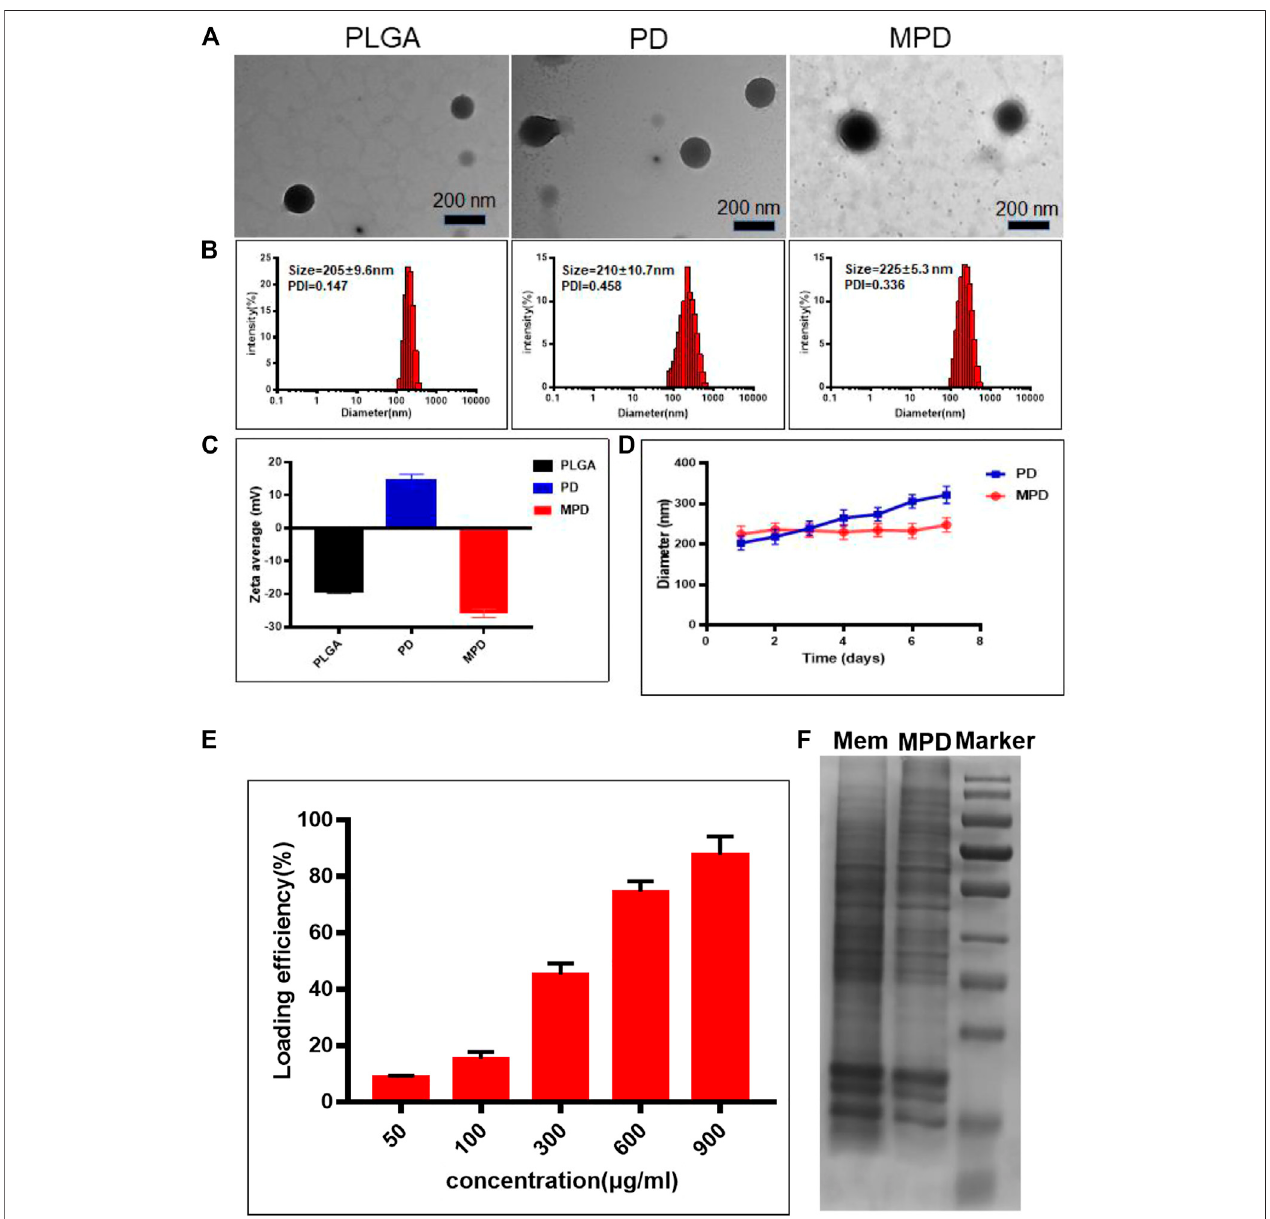
FIGURE 1 | Characterization and degradation of PLGA-based nanoparticles. (A) TEM image of different nanoparticles. Scale bar: 200 nm. (B) DLS analysis of PLGA-based nanoparticles. (C) Surface zeta potential of PLGA-based nanoparticles ( n (cid:1) 3). (D) Stability analysis of PLGA and MPD ( n (cid:1) 3). (E) Loading capacity assessment of MPD with different concentrations of DiR ( n (cid:1) 3). (F) SDS-PAGE analysis of the surface proteins on MPD. PD, PLGA/DiR, MPD, LLC membranes/ PLGA/DiR.